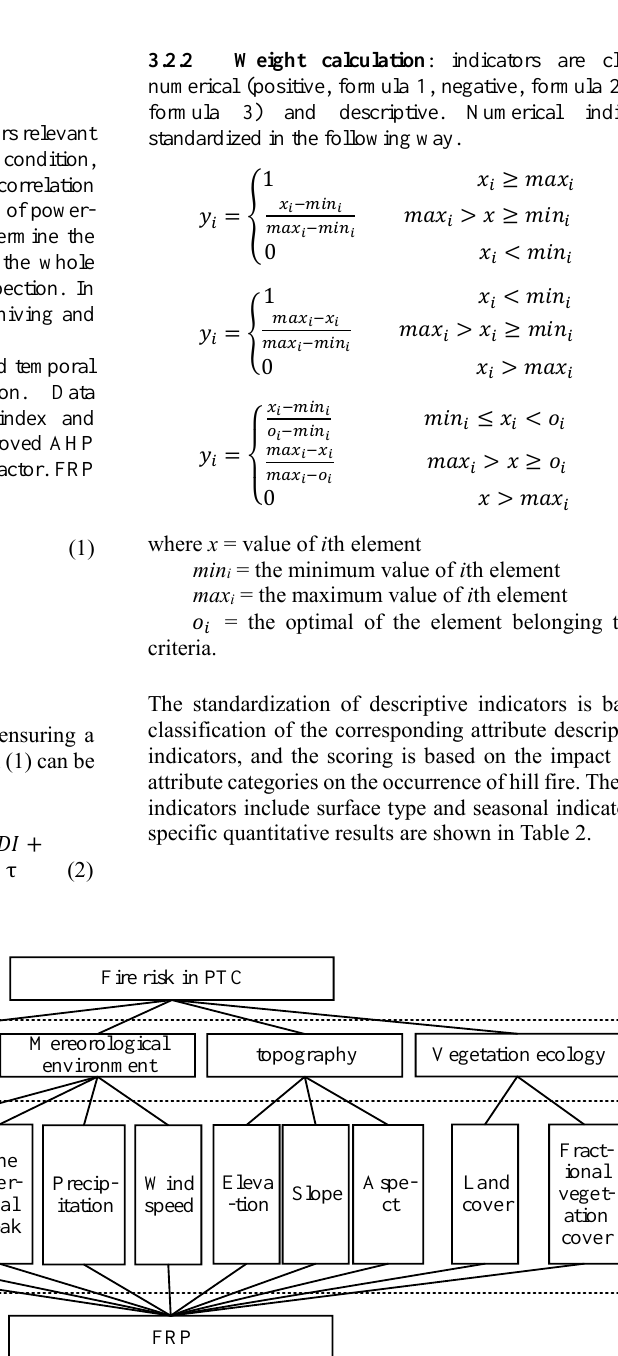
Table 1 . Relevance analysis between fire frequency and impact factors.